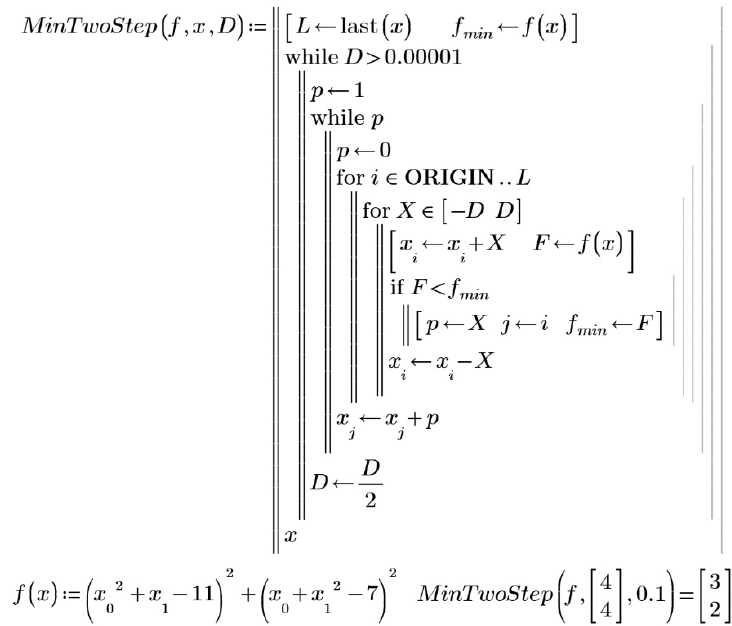
Figure 23. Snapshot of the code of the user program in Mathcad.